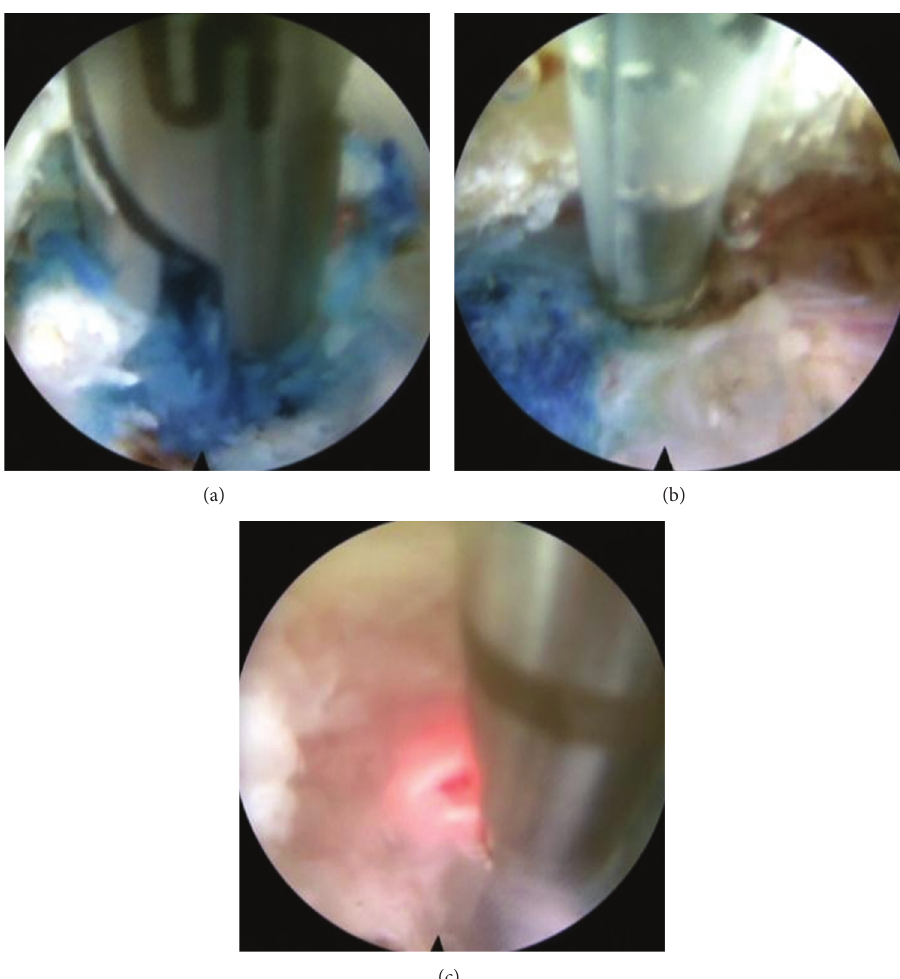
Figure 5: The herniated disc material was removed using a grasper (a), radiofrequency (b), and the Holmium-YAG laser (c).